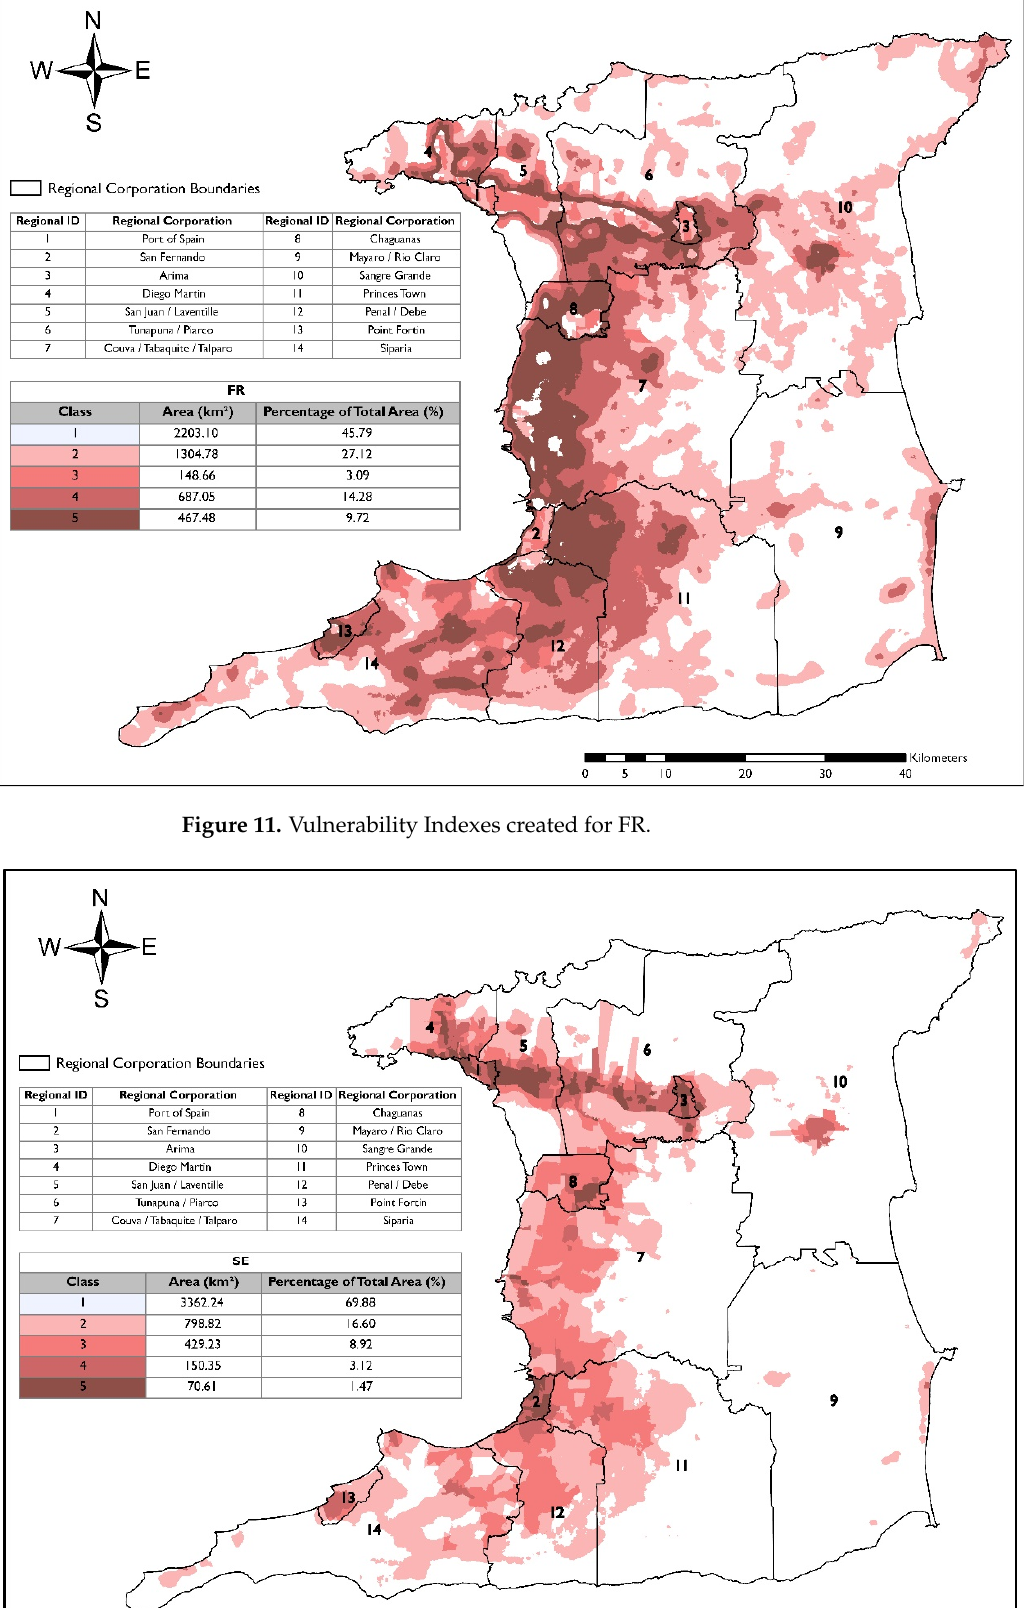
Figure 10. Vulnerability Indexes created for AHP.